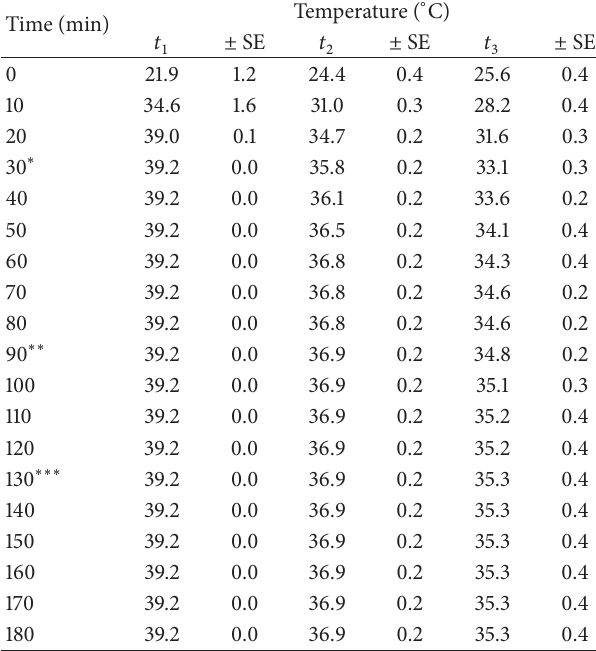
Table 1: Dynamics of warming-up of the measuring system’s components (𝑛 = 6)